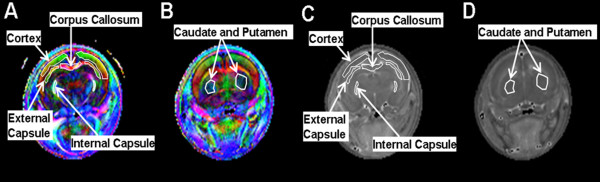
In vivo diffusion tensor imaging of a control rat at postnatal day 8. In the fractional anisotropy-based color coded axis maps (A and B), the colors are used to indicate the preferred diffusion direction in a coronal plane. Red, green, and blue represent transverse, dorso-ventral and rostro-caudal directions, respectively. The brightness is coded by the FA value. On this map, both white matter (corpus callosum, internal capsule, and external capsule) and grey matter (cortex, caudate and putamen) can be identified. C and D are mean diffusivity maps showing the same structures.